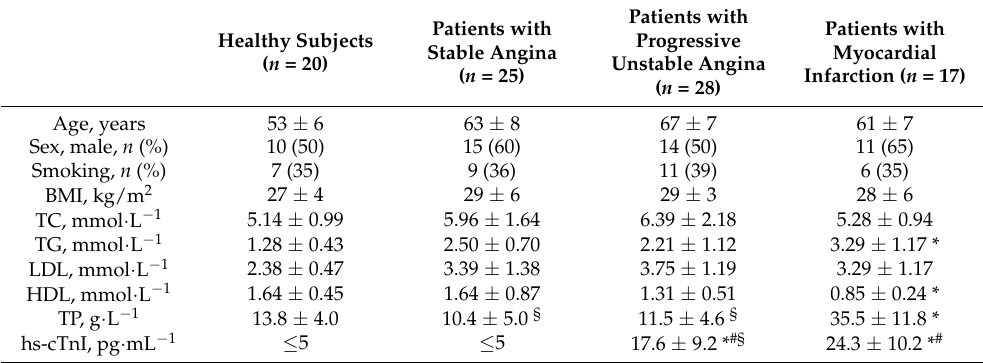
Table 2. The concentration of peptides in plasma of patients with CAD, and healthy subjects. Peptide Concentration, Groups µ g per mL of Plasma Healthy subjects ( n = 20) 68 ± 18 Patients with stable angina ( n = 25) 336 ± 17 * § Patients with progressive unstable angina ( n = 28) 428 ± 27 * #§ Patients with myocardial infarction ( n = 17) 987 ± 64 * # Values are expressed as mean ± SD; * p < 0.05 significantly different from control subjects; # p < 0.05 significantly different from group of patients with stable angina; § p < 0.05 significantly different from group of patients